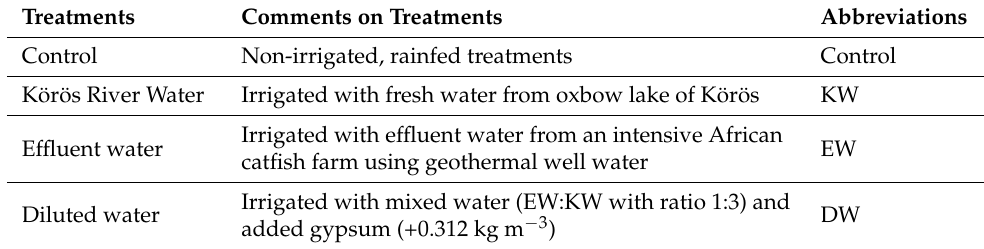
Table 2. Summary table of treatments.